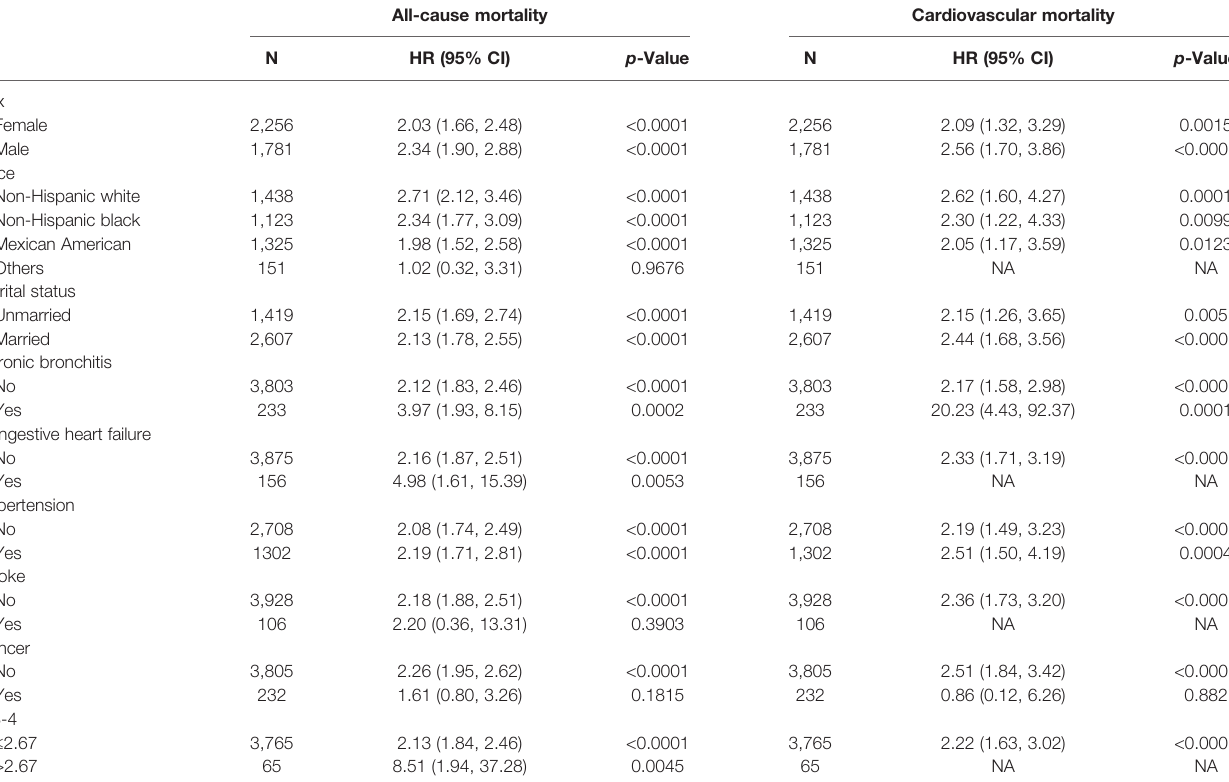
TABLE 3 | Strati fi cation analyses of the association of DM with all-cause mortality and cardiovascular mortality in individuals with NAFLD. All-cause mortality Cardiovascular mortality